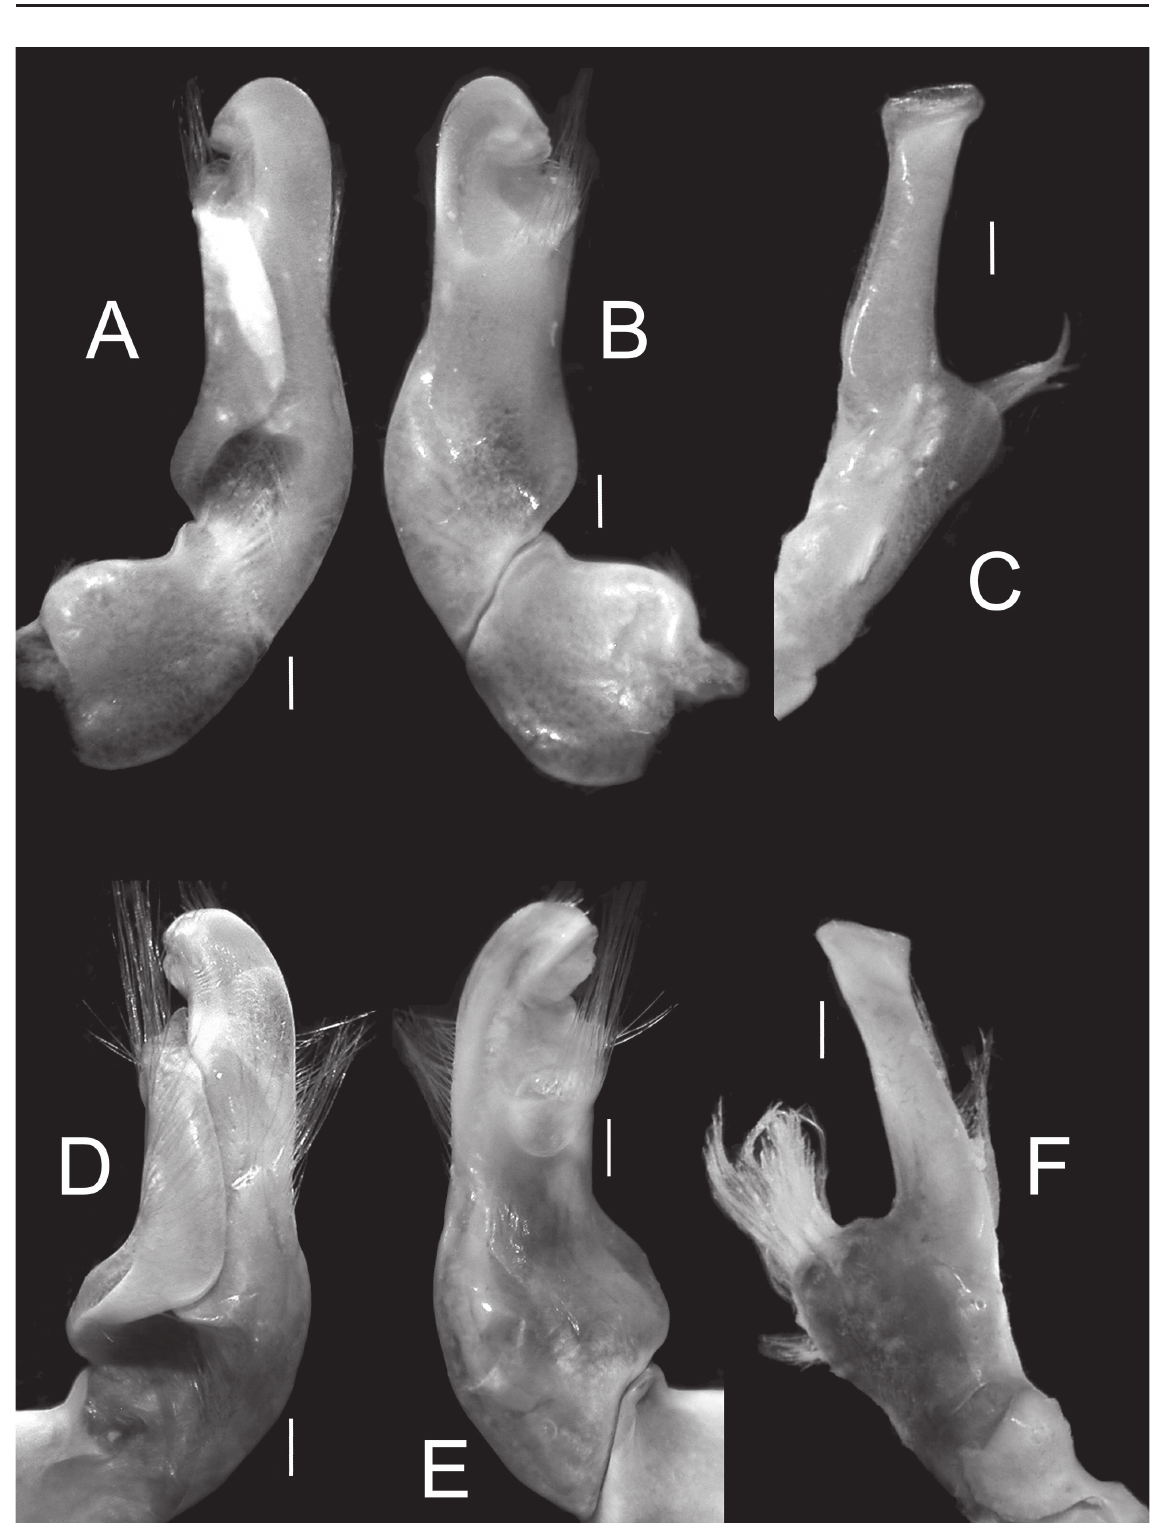
Fig. 16. Gonopods. A – C . Moloha alisae Guinot & Richer de Forges, 1995. Holotype, ♂ (cl 36.1 mm, cw 29.7 mm) (MNHN-IU-2008-11077), Seychelles. D – F . Moloha alisae Guinot & Richer de Forges, 1995. ♂ (cl 67.7 mm, cw 56.2 mm) (ZRC 2008.1250a), South Africa. — A , D . Ventral view of left G1. B , E . Dorsal view of left G1. C , F . Left G2. Scale bars =